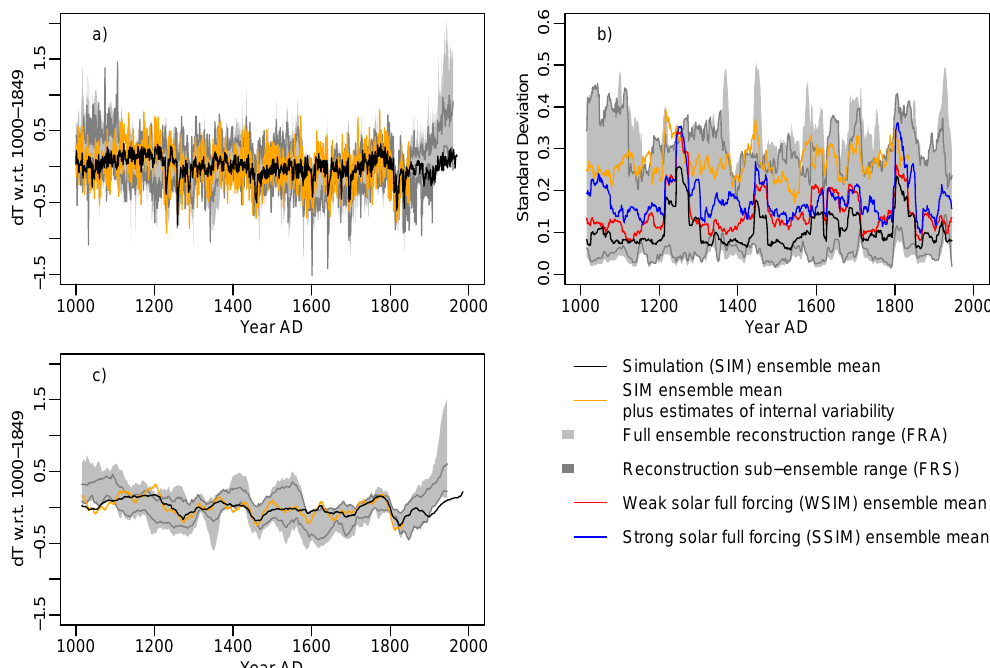
Fig. 3. (a) Time series, (b) moving 31yr standard deviations and (c) moving 31yr means for the FRA Northern Hemisphere temperature reconstruction ensemble against the simulated target. Black is the verification data target and transparent light grey shading is the range of the FRA ensemble. Dark grey lines mark the range of the FRS reconstruction sub-ensemble recalibrated to the period 1920–1960. The orange line is the estimate of the target with added internal variability estimate. In (b) red (blue) lines are for the weak (strong) solar full-forcing simulation ensemble means.